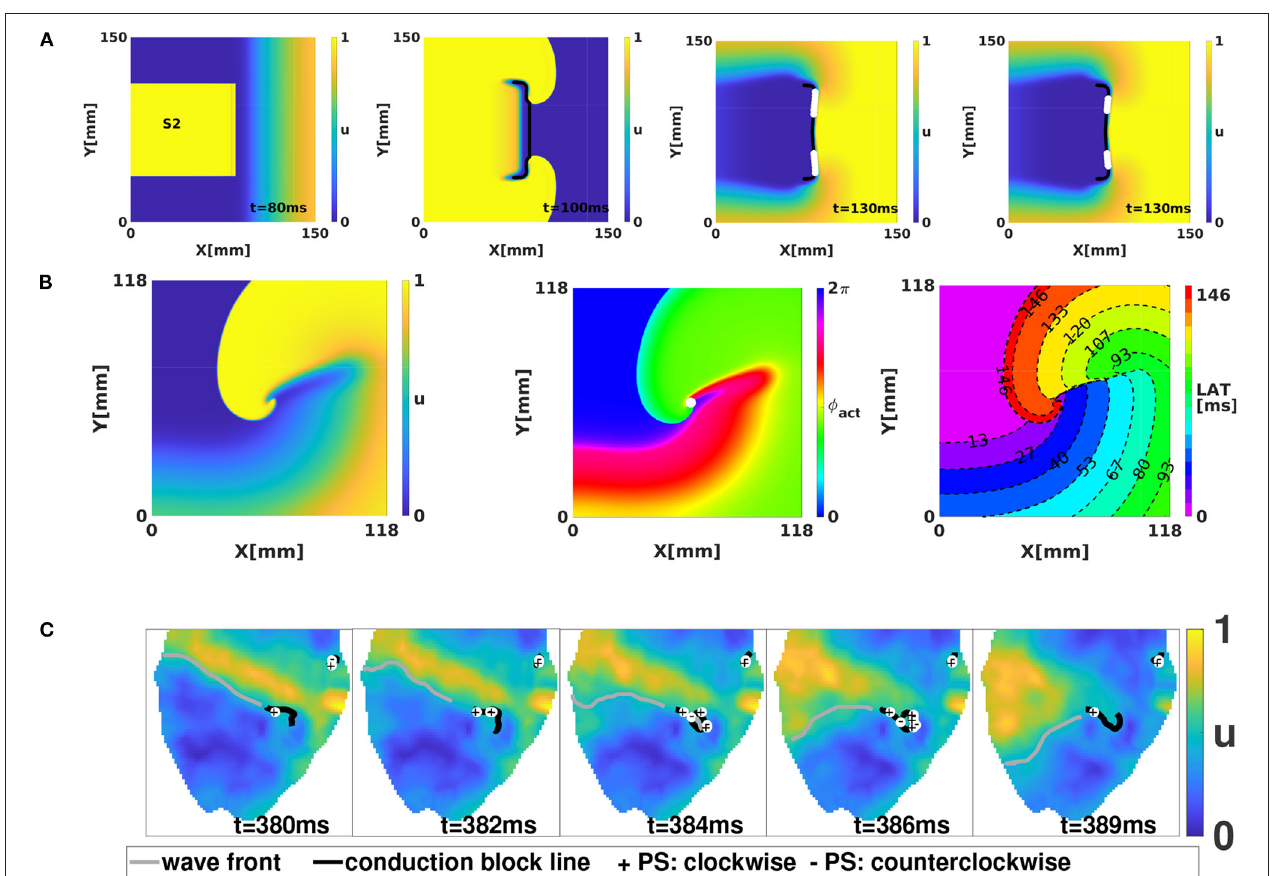
FIGURE 2 | Limitations of current PS detection algorithms. (A) Application of the S1-S2 stimulation protocol in the BOCF (Bueno-Orovio et al., 2008) model to initiate a rotor. White dots denoted detected PSs with either a 2 methods identify multiple PS on the CBL (black line). (B) A linear-core rotor in the Fenton Karma model, from 3 perspectives: transmembrane voltage (left), activation phase (middle panel) with PS indicated (white) and LAT (right). (C) Optical mapping of rabbit hearts during ventricular tachycardia showing that detected PSs are all located on